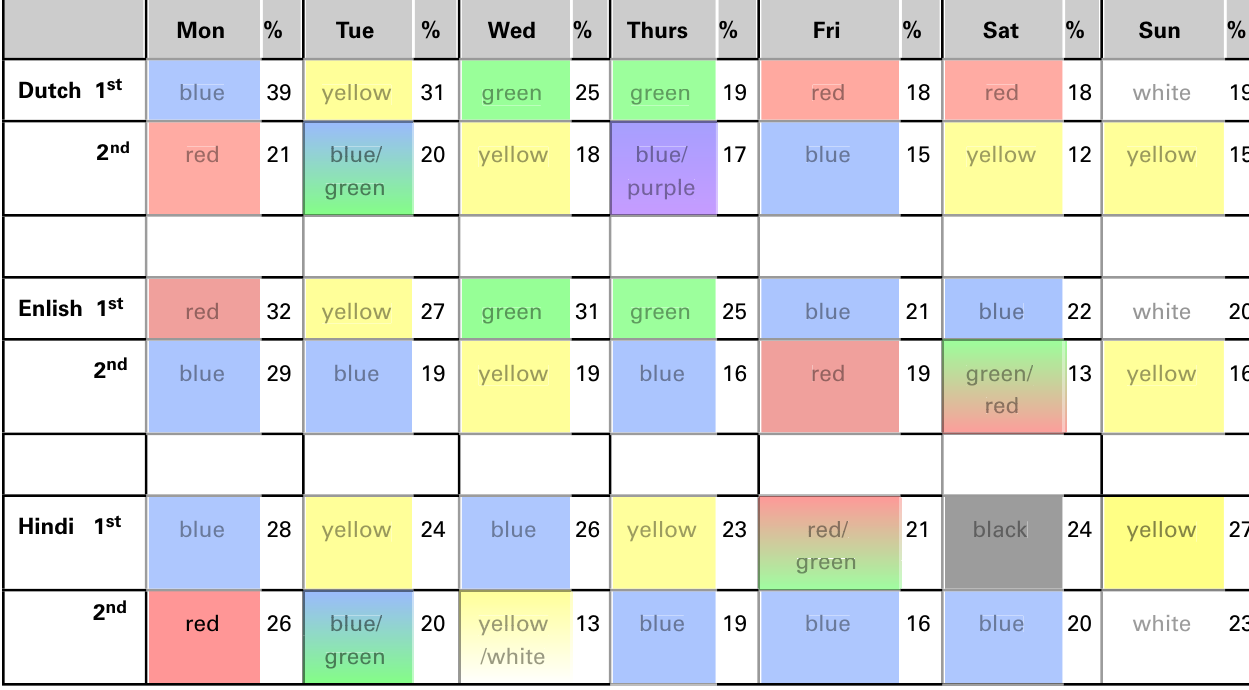
Table 2 | Consistency between languages for day-color preferences. Mon % Tue % Wed % Thurs Dutch 1